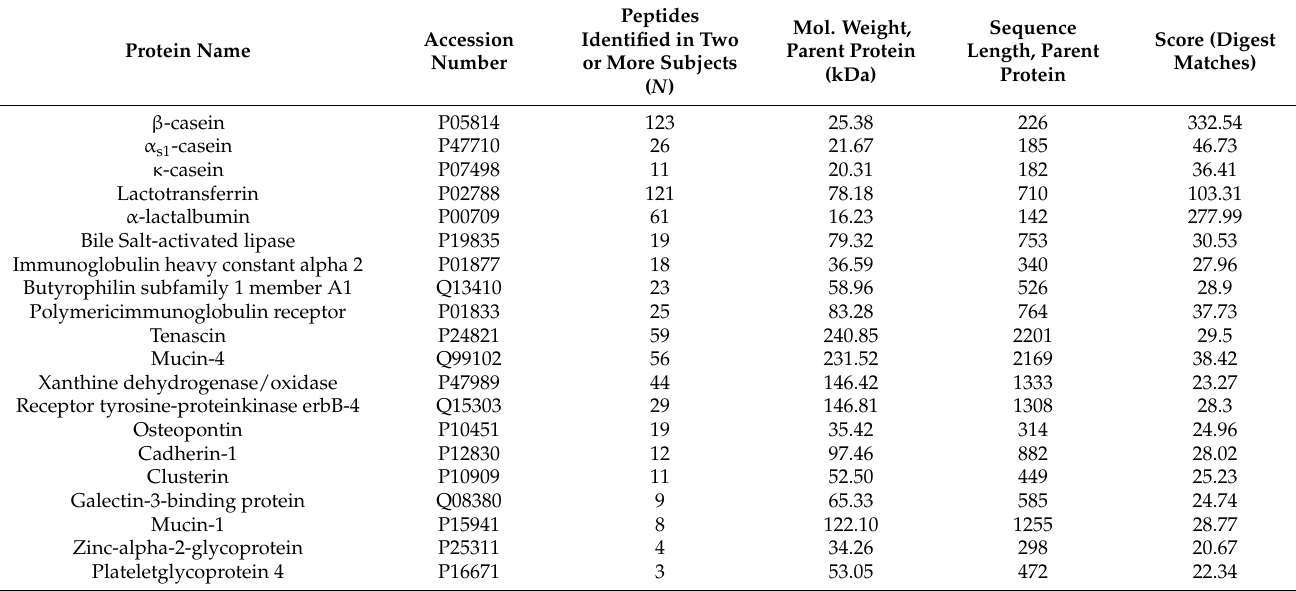
Figure 5. Peptigram profile of β -casein ( a ), α -LA ( b ) and lactoferrin ( c ) derived peptides in digests of human milk ( N = 10) after 60 min gastric digestion (FG60), and 5 min (FI5) and 60 min (FI60) intestinal digestion. Table 2. Number identified of peptides and corresponding proteins after individual in vitro digestion of breast milk from NW ( N = 6) and OW/Ob ( N = 4)